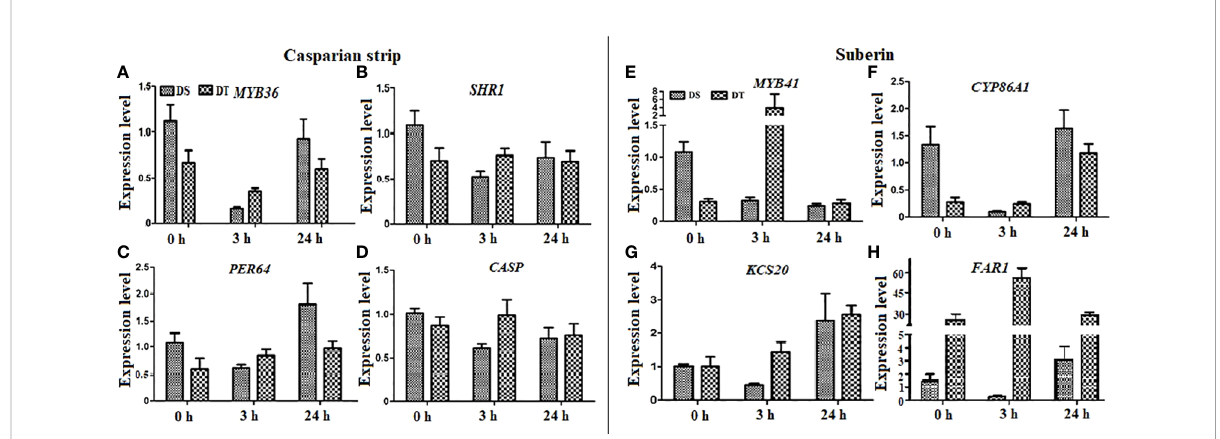
FIGURE 7 Expression levels of apoplastic barrier-related genes in drought-tolerant (DT) and drought-sensitive (DS) genotypes under osmotic stress conditions.Twenty-eight-day-old seedlings were subjected to 20% (w/v) PEG 6000 treatment for 0, 3, and 24 h. (A – D) Expression levels of Casparian strip-related genes. (E – H) Expression levels of suberin-related genes. DnaJ was used as a reference gene, and the relative expression levels of all genes were assessed using qRT-PCR. Values are mean ± standard deviation (SD) (n =